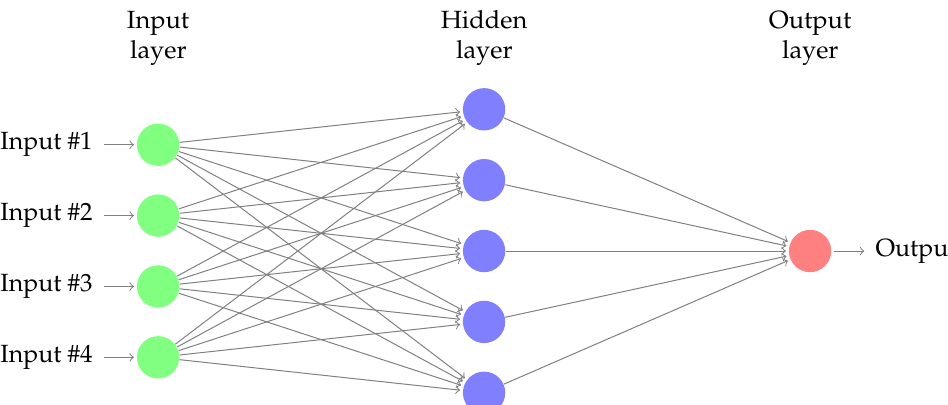
Figure 2. General architecture of a Deep Learning